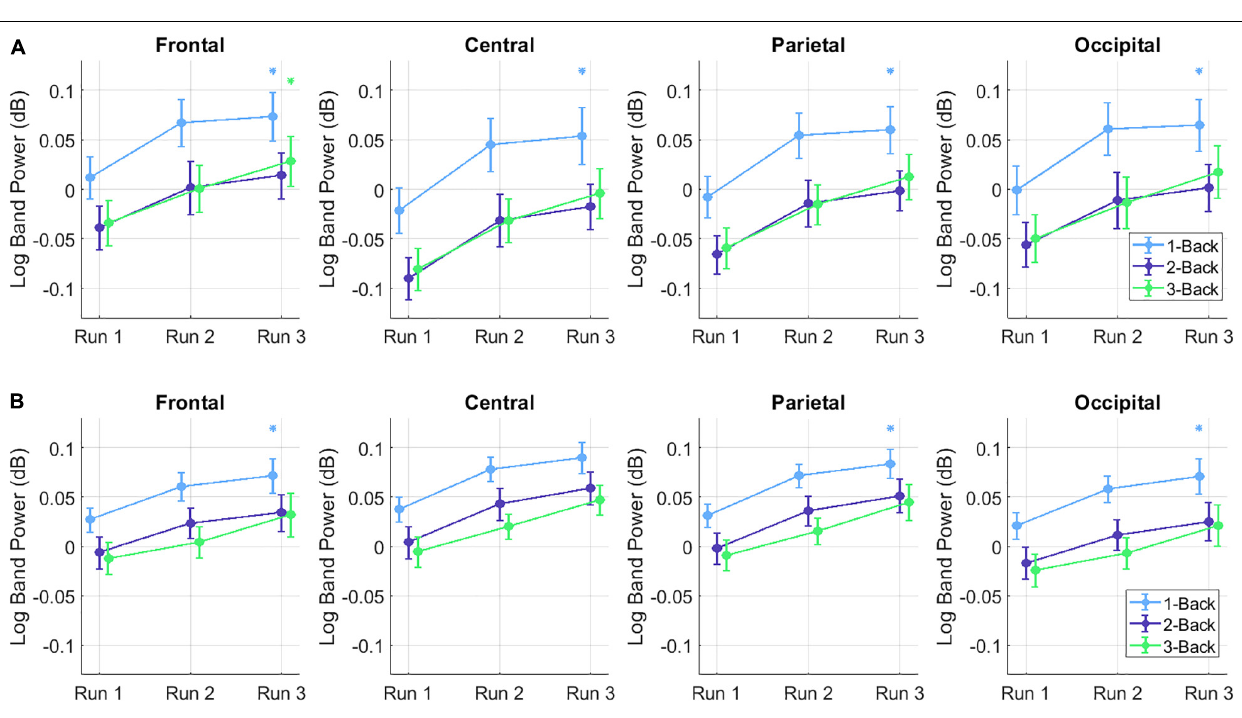
FIGURE 5 | Mean ± SE of the (A) theta and (B) alpha BP changes in the low and high PG for each run, task (color-coded) and ROI (i.e., frontal, central, parietal, and occipital). Asterisks denote statistically significant differences ( p < 0.05) between low and high PG. The color of the asterisk represents a specific task (i.e., 1-back: blue, 2-back: purple, or 3-back: